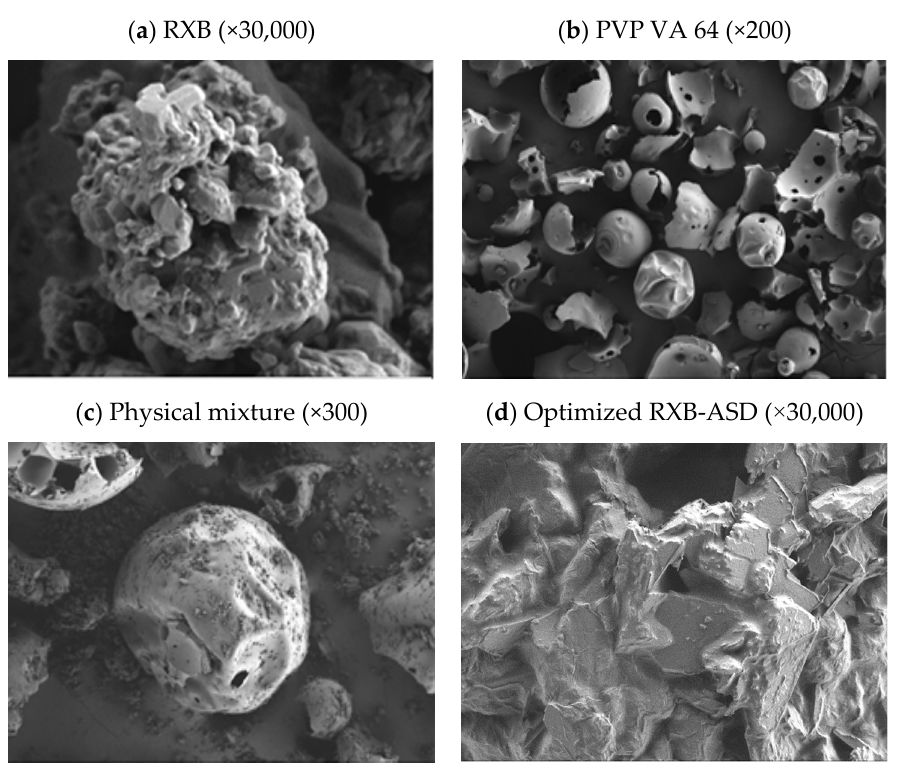
Figure 7. SEM images of samples: ( a ) RXB; ( b ) PVP VA64; ( c ) physical mixture; ( d ) optimized RXB-ASD.